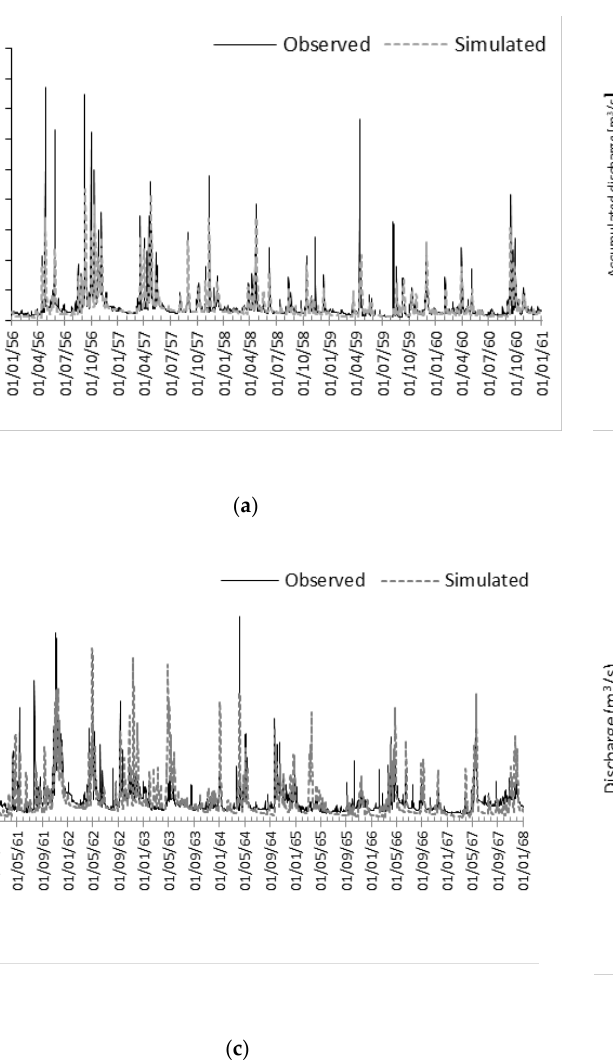
( a ) ( d ) Figure 4. Mubuku calibration plot ( a ), accumulated discharge plot ( b ), Validation plot ( c ) and Flow Duration Curve ( d ).